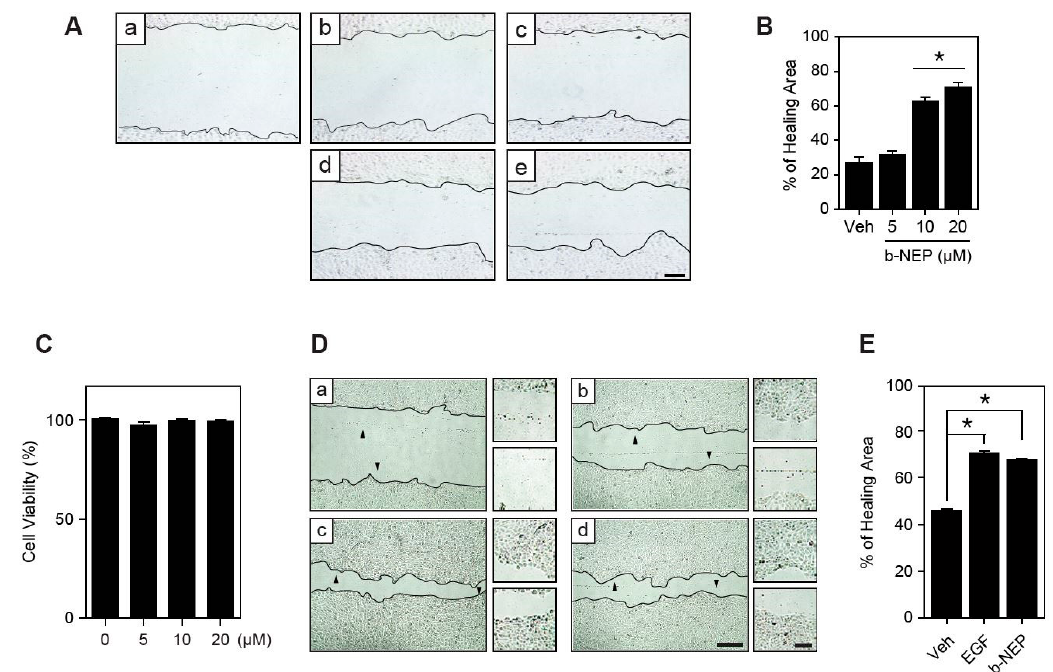
Figure 1. β -neoendorphin ( β -NEP) promotes wound healing in human keratinocyte. ( A ) Dose-dependent wound healing e ff ect of β -NEP. Human keratinocyte (HaCaT) cells were grown to confluence and scratch wound was created using pipet tips (a, T0). Cells were incubated for 20 h in the absence (b, Veh) or presence of 5, 10, 20 µ M of β -NEP, respectively (c–e). Scale bar = 100 µ m. ( B ) The wound area was measured and percent wound healing calculated using ImageJ software. ( C ) Cell viability was assessed by MTT assay after β -NEP treatment for 24 h. ( D ) HaCaT cells were grown to confluence and scratch wound was created using pipet tips (a, T0). Cells were incubated for 20 h in the absence (b, Veh) or presence of epidermal growth factor (EGF) (30 ng / mL, c) and β -NEP (10 µ M, d). Scale bar = 200 µ m. The arrowhead indicates that the region of magnification and magnified cell image are located on the right (scale bar = 20 µ m). ( E ) Percent wound healing from ( D ). Photomicrographs were acquired using an AxioObserver FL microscope at 10 × magnification. Results represent the means of three independent experiments. Data represent mean value ± SEM (* p < 0.05, one-way ANOVA Friedman’s test).